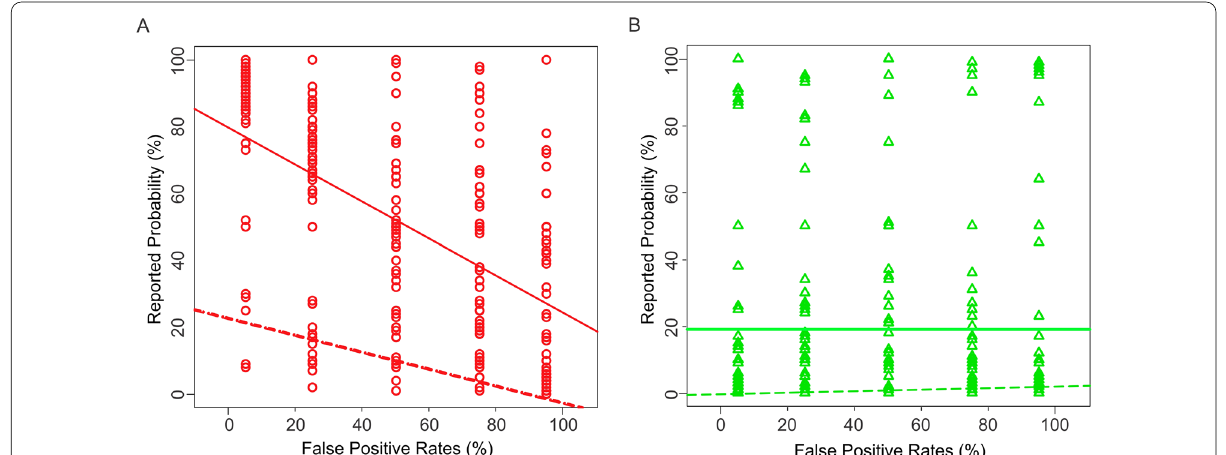
Fig. 2 The interaction between the false alarm rate and the binary decision of the system in Experiment 1, as revealed by one-way ANCOVA. For visual clarity, the data corresponding to the two decisions of the CAD system (mammogram positive or negative for cancer) are shown separately in ( A and B ), respectively. In either panel, each data point denotes a single trial, and the solid and dashed lines denote best-fitting regression line for the observed and the expected responses, respectively. See text for